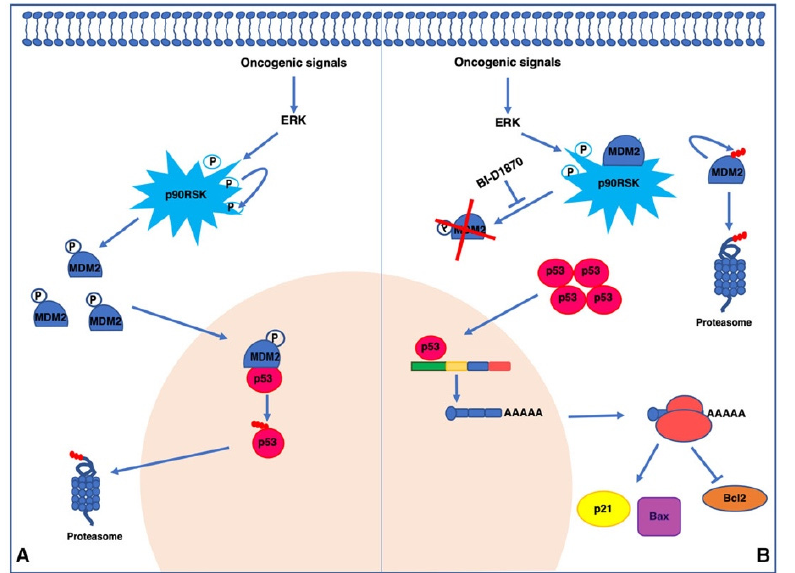
Figure 8. Final model of p53 degradation dependent on MDM2 phosphorylation by p90RSK. ( A ) In tumor cells, oncogenic signals lead to the activation of p90RSK via ERK. Activated p90RSK is capa- ble of phosphorylating itself and various substrates including the ubiquitin ligase MDM2 on serine 166. This phosphorylation protects MDM2 from degradation, stabilizing it. MDM2, in turn, induces